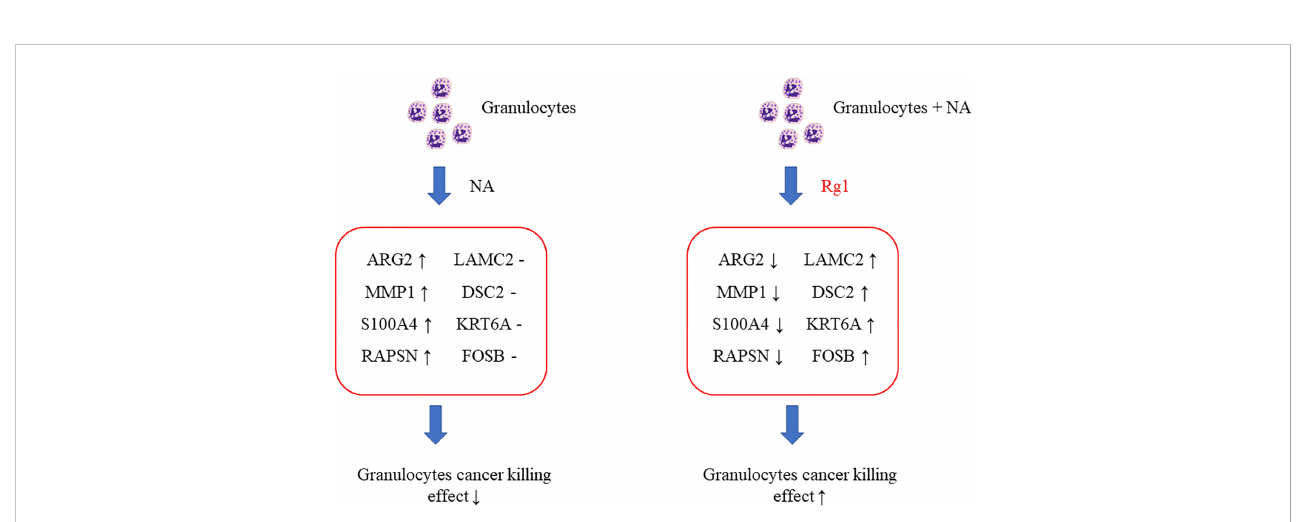
FIGURE 7 Schematic diagram about the mechanism of ginsenoside Rg1 promoting the anti-cancer function of granulocytes immunosuppressed by noradrenaline